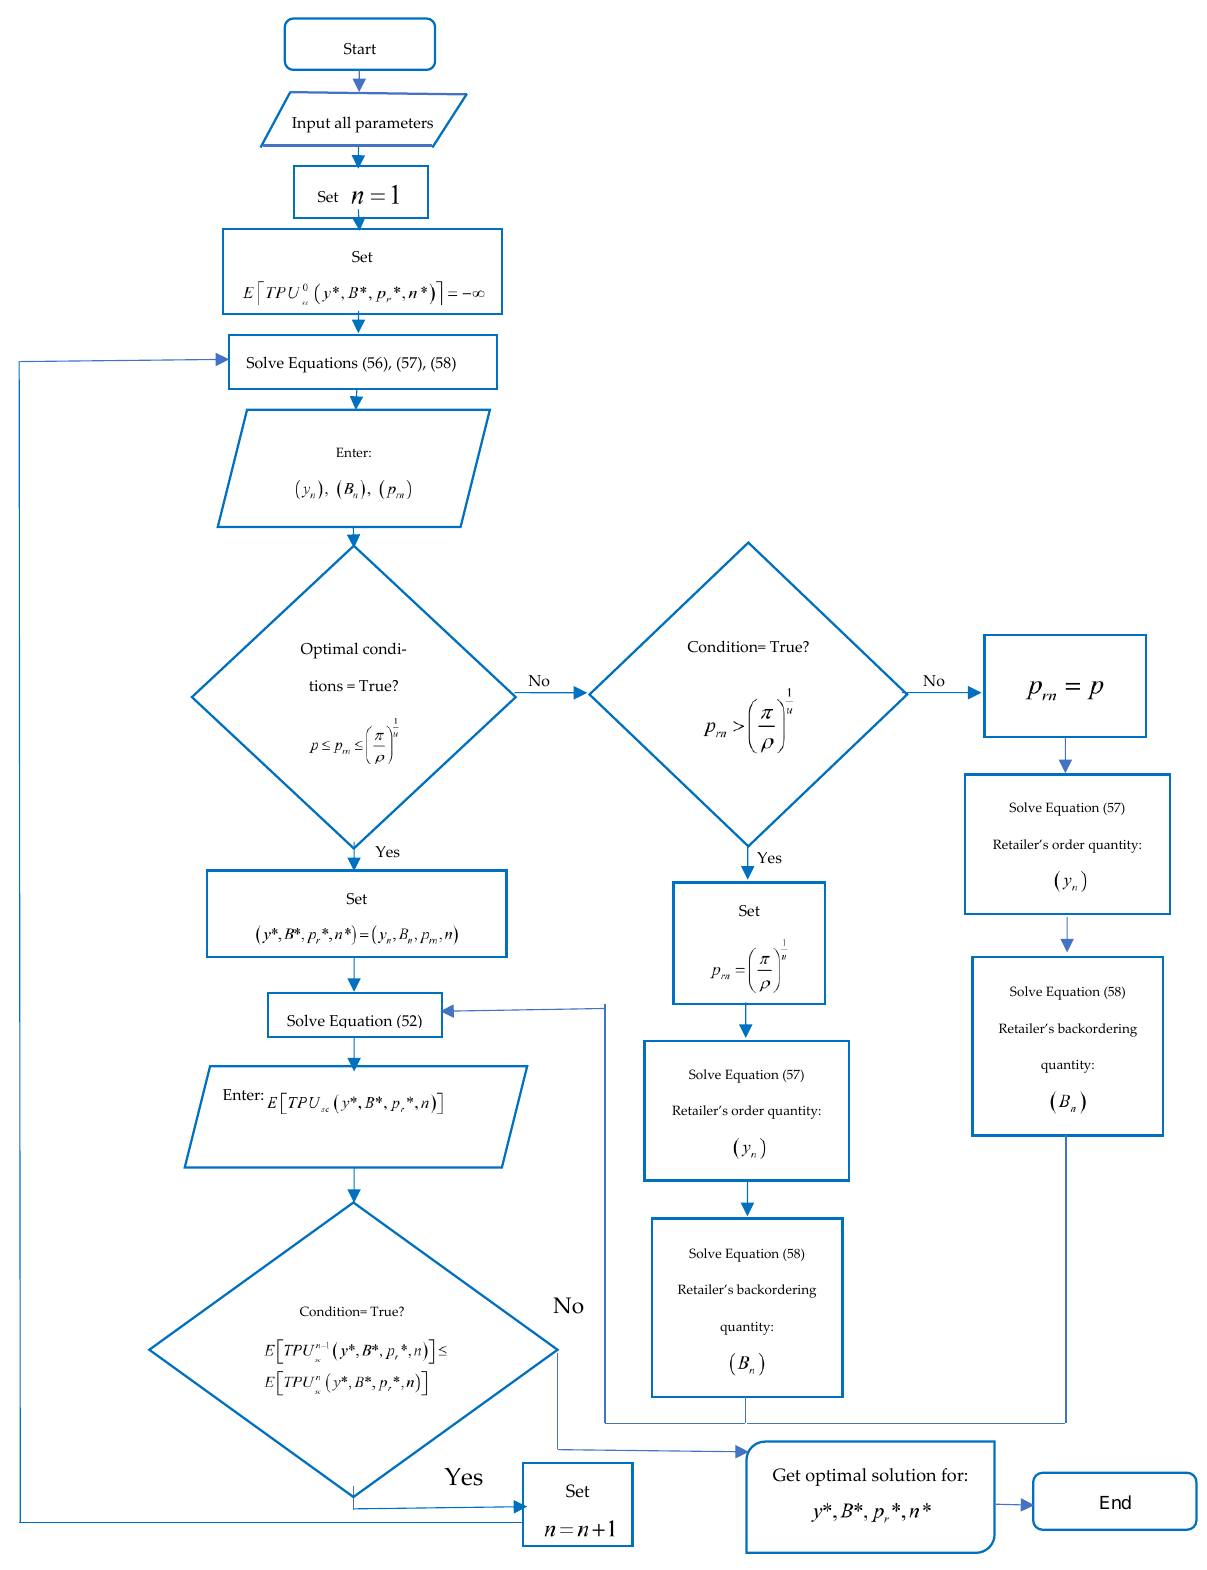
Figure 7. Algorithm for finding the optimal